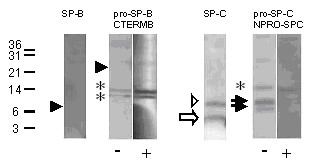
SP-B deficiency. Western blotting of a lavage from patient SP-B 06 homozygous for the 121ins2 SFTPB mutation. After SDS-PAGE and transfer, the membranes were probed with the antibodies indicated. The pro-forms were probed in the absence (-) and presence (+) of an excess of the peptide used to raise this antibody. Note that bands that are not displaced by the competing peptide were not considered as specific bands (marked by an asterisk). The numbers next to the lanes indicate the molecular weight in kDa. The closed arrowheads indicate the absence of SP-B and of proforms of SP-B. Arrows show the presence of SP-C (open arrow) and of abberant pro-SP-C (closed arrows). Some aberrant pro-SP-C can also be seen on the SP-C blot, above the SP-C band, which is indicated by an open arrowhead. All bands were analyzed under reducing conditions.